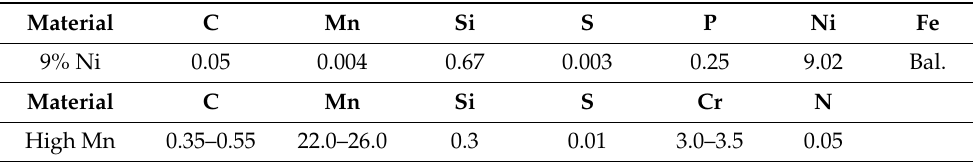
Table 1. Chemical composition of base metal.